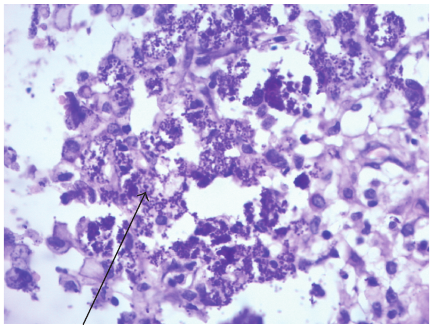
Figure 6: PAS fungal stain. PAS stain: depicting basophilic intracel- lular bodies within the macrophages (arrow) consistent with Histo- plasma capsulatum . There is no evidence of granulomatous